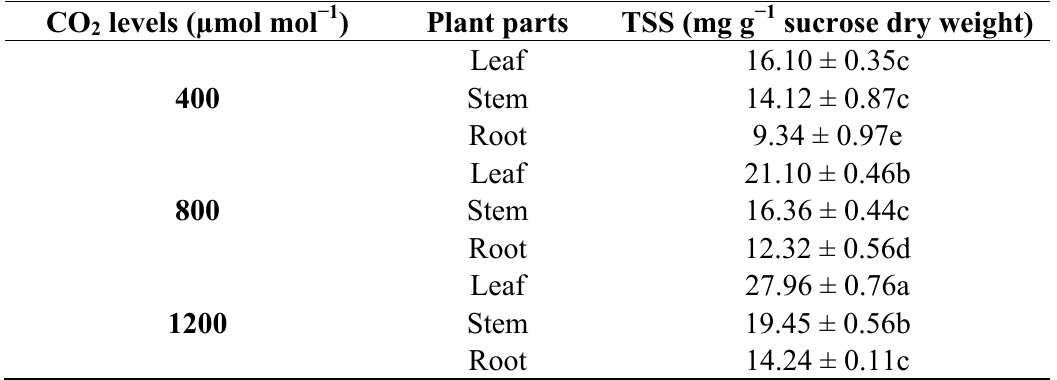
Table 5. Accumulation and partitioning of total soluble in different plant parts of L. pumila levels Blume. under different CO 2